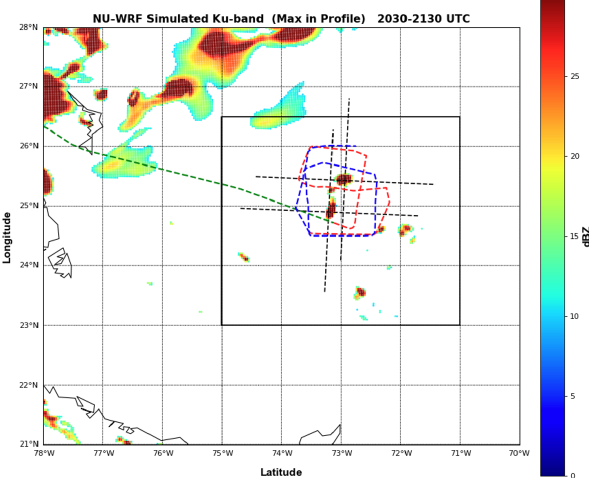
Figure 10. Plan view of the NU-WRF simulated DPR Ku band (maximum reflectivity in the profile) for the 21:00UTC analysis. The dashed lines indicate the locations of the E–W and N–S cross sections shown in Fig. 11, crossing at locations 25.5 ◦ N, 73 ◦ W and 25 ◦ N, 73.3 ◦ W. The green, red, and blue dashed lines indicate the DC-8 flight tracks between 18:30–19:30, 19:30–20:30, and 20:30– 21:30UTC,